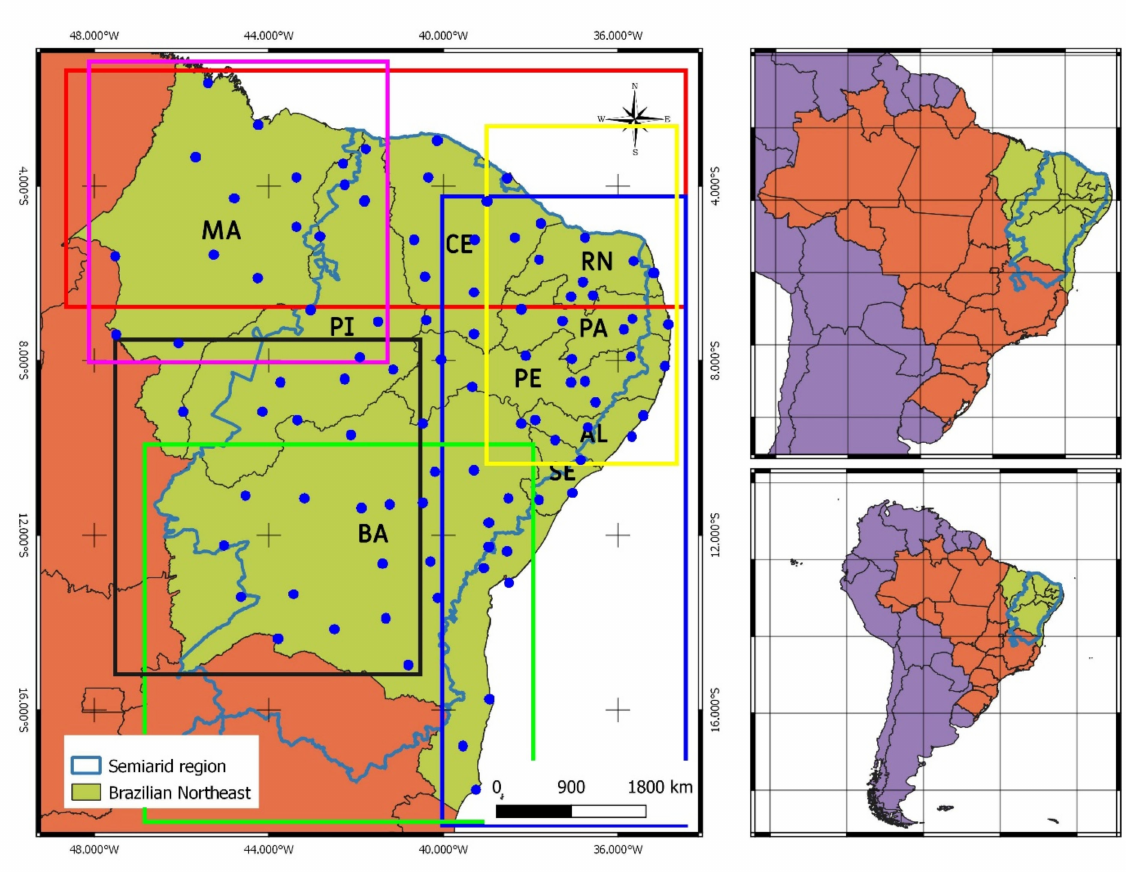
Figure 1. Map of the NEB ( left ) with the delimitation of the semiarid region and its location relative to Brazil ( top right ) and South America ( bottom right ). In the left panel, the blue points represent INMET’s weather stations. The climate subregions that are referred to throughout this study are graphically presented in the left panel encompassed by rectangles with the following colour associations: northern NEB, red; northwestern NEB, pink; northeastern NEB, yellow; eastern NEB, blue; southern NEB, green; southwestern NEB, black. Extracted from